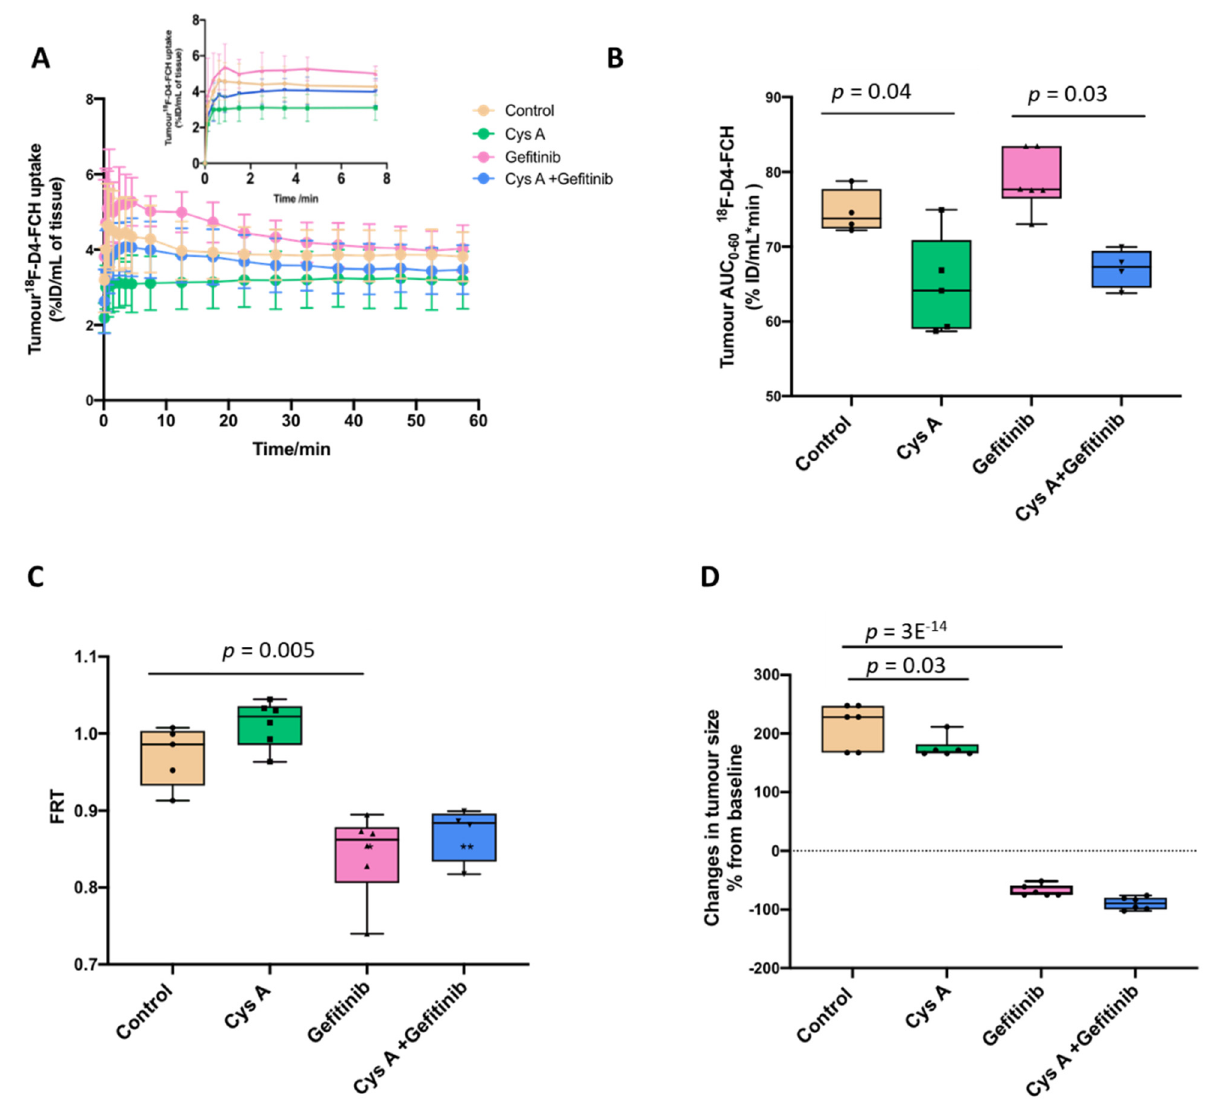
Figure 6. The in vivo 1-h dynamic imaging of [ 18 F]-D4-FCH in PC-9 human NSCLC xenograft-bearing mice. ( A ) The time versus radioactivity curves (TACs) in the vehicle control (0.4% Tween 80) or ABC transporter modulator-treated mice; inset: expanded TACs at the early time points. ( B ) Data from the TACs expressed as an area under the radioactivity versus TAC curves, (AUC 0 to 1 h). ( C ) Data from the TACs expressed as the fractional retention (FRT; NUV 60 /NUV 3.5 ) across the treatment groups. ( D ) The tumour burden of mice ( n = 24; n = 6 for each treatment) following the 20 mg/kg gefitinib treatment prior to the PET scan. The data presented are the mean ± standard deviation; the average and quartile levels are shown .